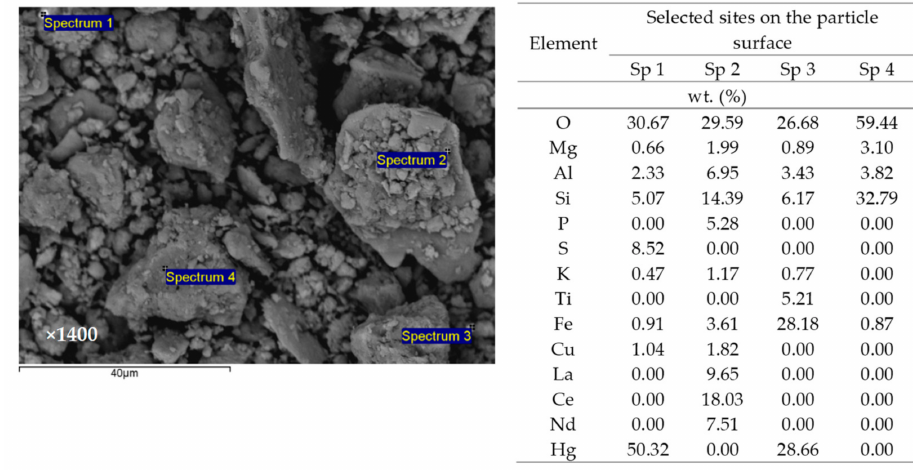
Figure 2. SEM image of mercury-contaminated soil particles with four selected sites (spectra, Sp) for EDS analysis and corresponding EDS